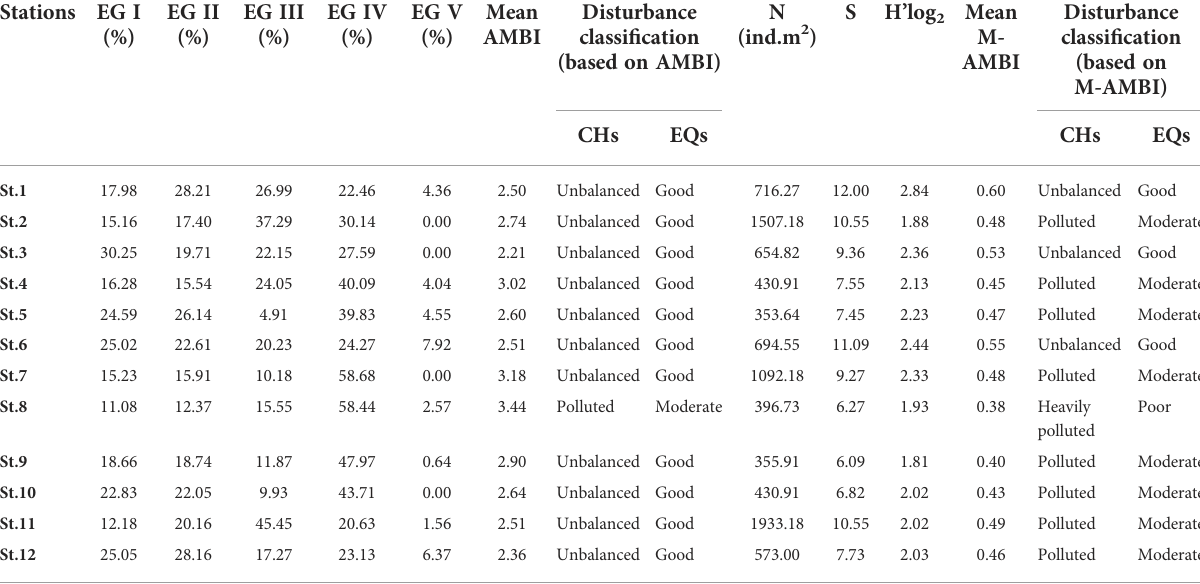
TABLE 4 Results of AMBI, M-AMBI and biodiversity of macrobenthos from Mahanadi estuary, during February 2013-March 2017. Stations EG I (%)